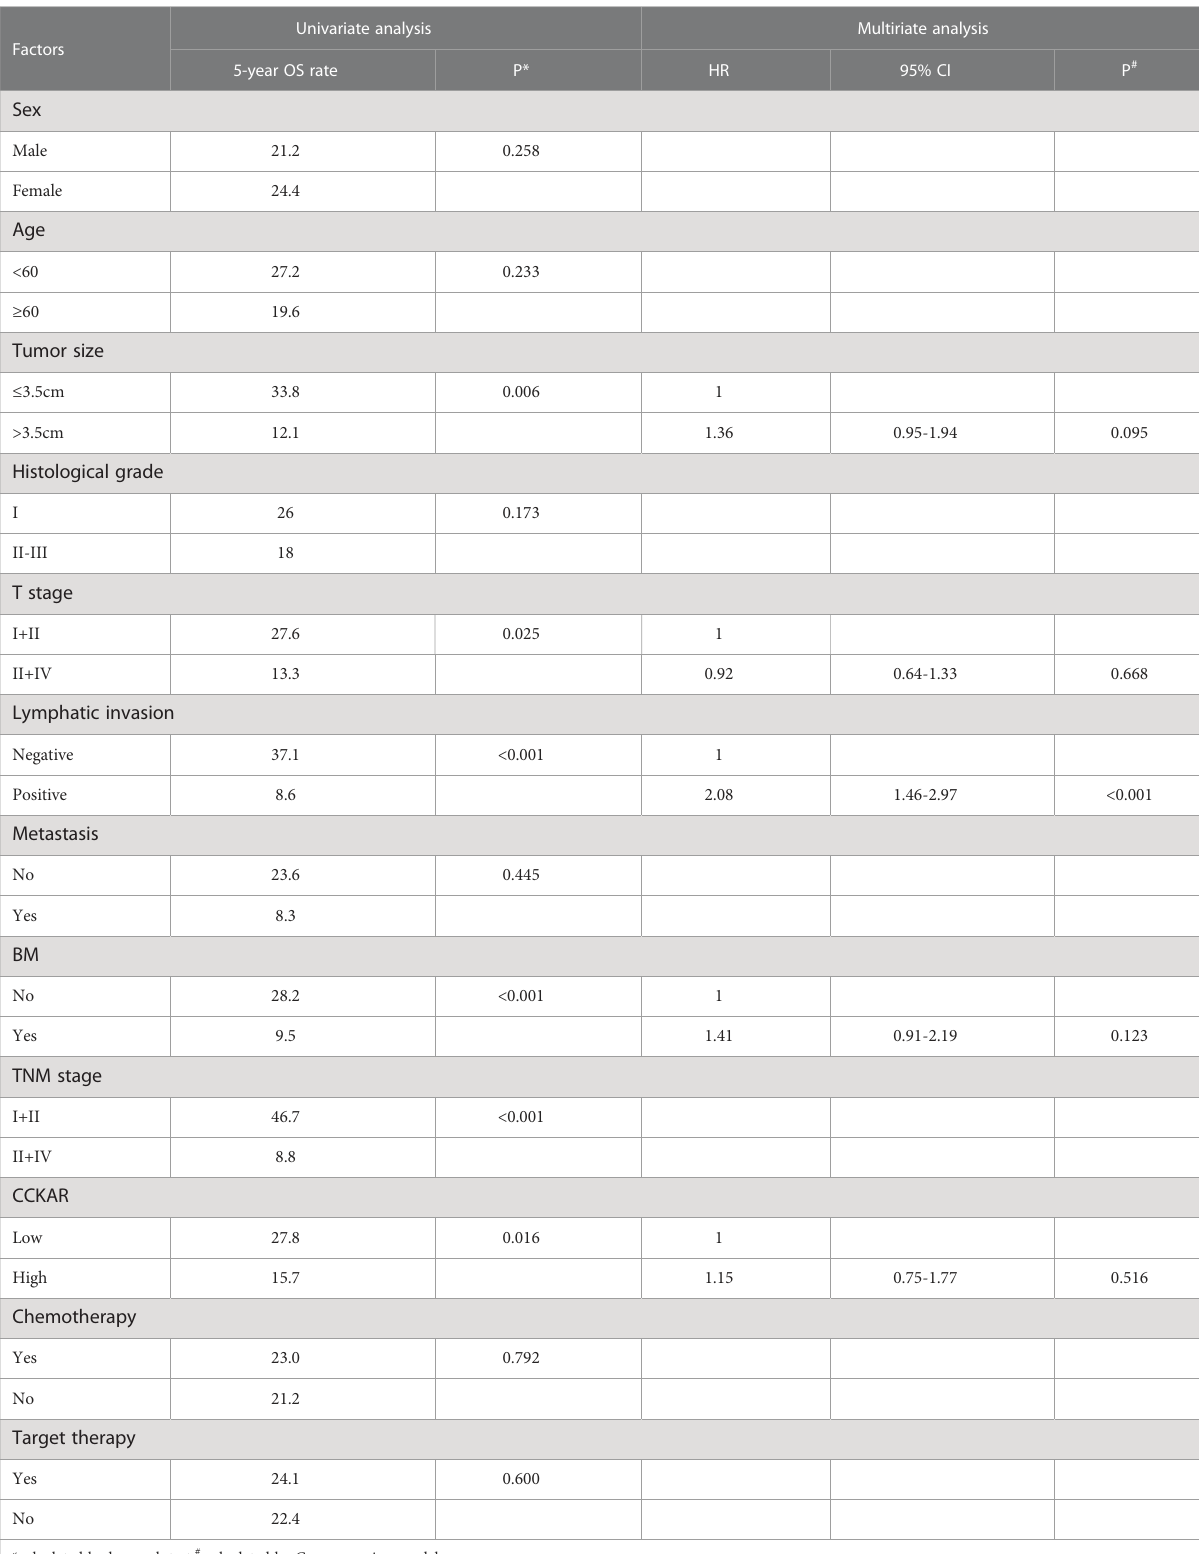
TABLE 2 The prognostic signi fi cance of CCKAR, BM and other clinicopathological